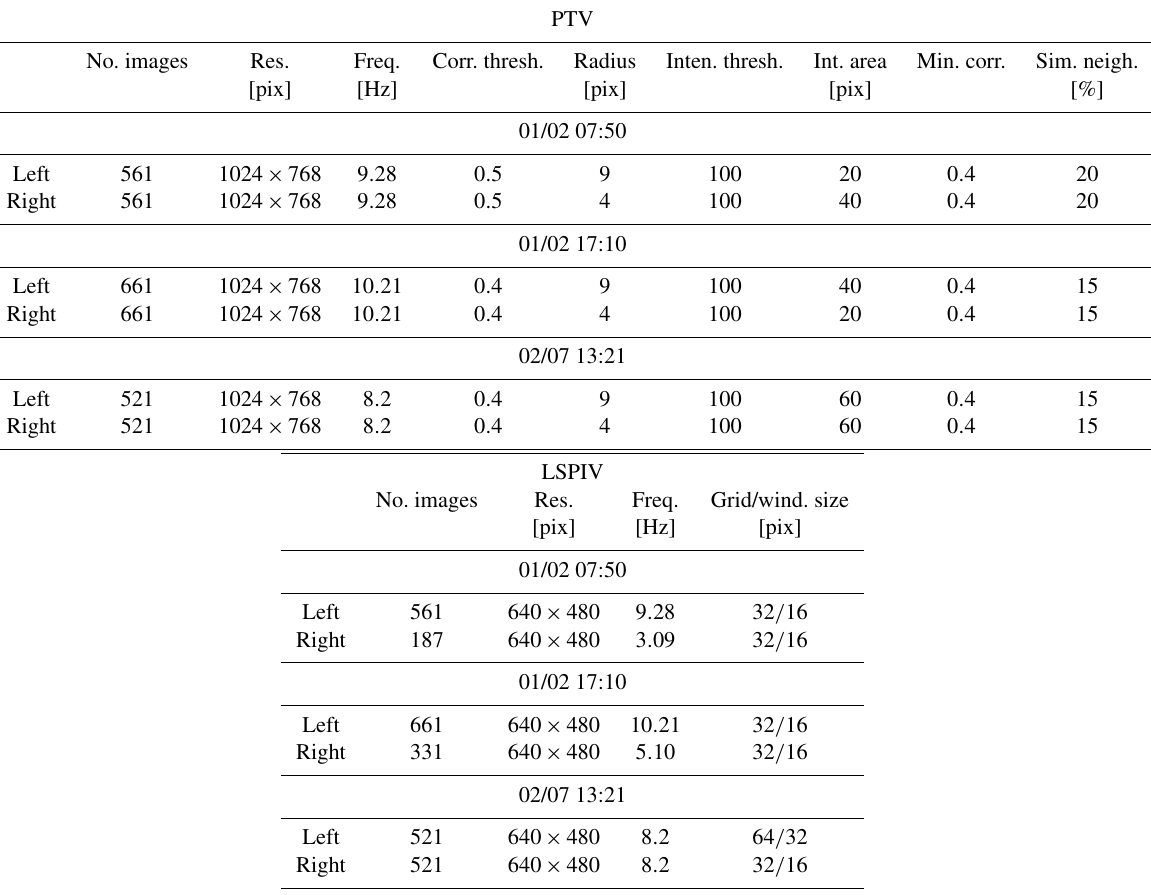
Table 2. Synoptic table for input PTV and LSPIV parameters. For each test, the following parameters are reported: number of analyzed images (no. images), image resolution (res.) and acquisition frequency (freq.), detection correlation threshold (corr. thresh.), radius, detection intensity threshold (inten. thresh.), interrogation area (int. area), minimum PTV correlation coefficient (min. corr.), neighbor similarity percentage (sim. neigh.), and LSPIV grid and interrogation window sizes (grid/wind.